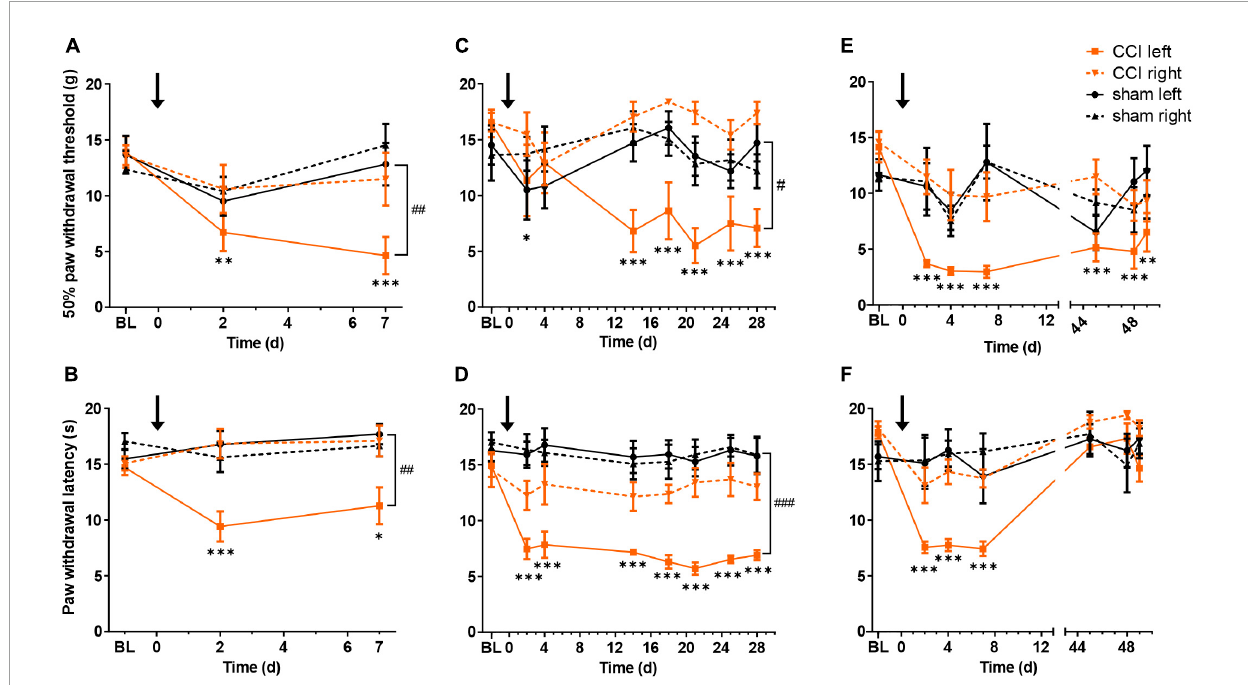
FIGURE1 Chronic constriction injury (CCI) of the left sciatic nerve induces long lasting mechanical and heat hypersensitivity. Mechanical paw withdrawal thresholds and radiant heat withdrawal latencies are shown for 1 week ( A,B , respectively), 4 weeks (C,D) or 7 weeks (E,F) following CCI (orange) or sham (black) surgery. Full lines indicate left paw (ipsilateral to surgery), dashed lines right paw (contralateral to surgery). BL indicates mean value of two baseline days. Black arrow indicates time of surgery (day 0). ∗ p < 0.05, ∗∗ p < 0.01, and ∗∗∗ p < 0.001, when comparing each testing day to baseline, for the CCI-treated hindlimb; # p < 0.05, ## p < 0.01, and ### p < 0.001, when comparing CCI- and sham-treated hindlimbs on the last testing day. n = 6 rats per